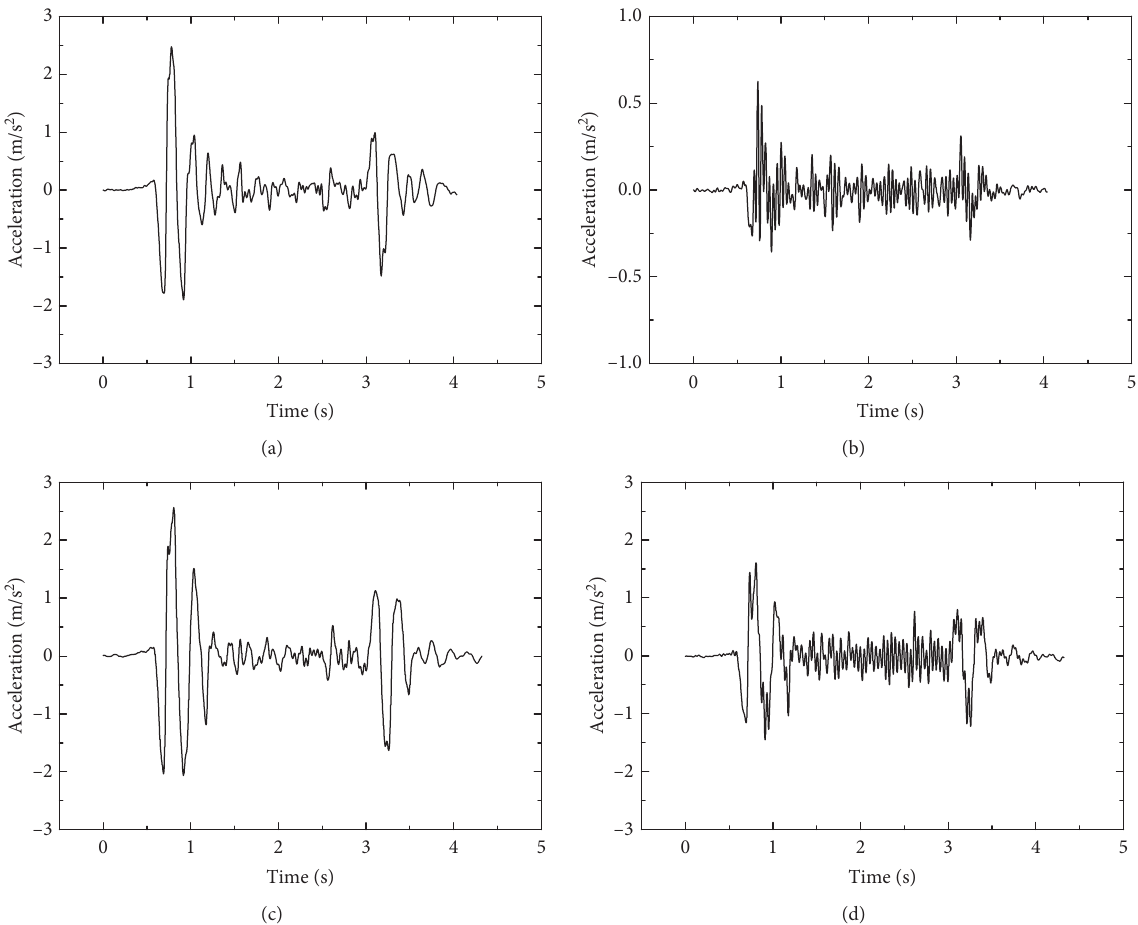
Figure 9: Measured acceleration time histories of SESB: (a) V 1; (b) V 2; (c) V 3; (d) V